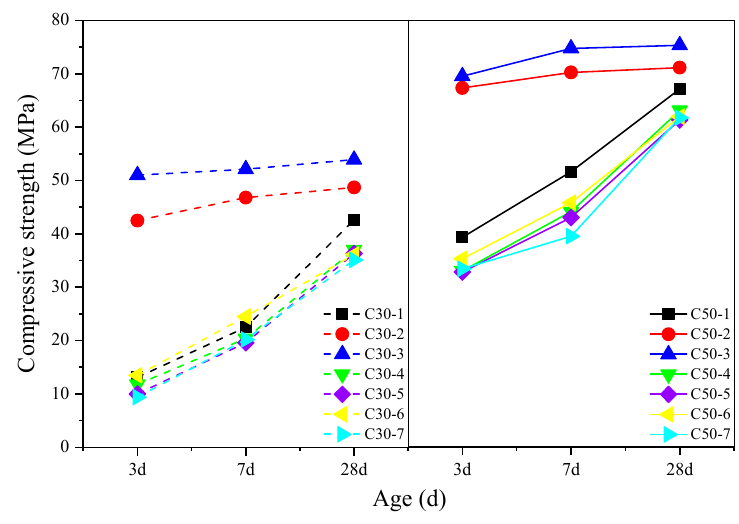
Figure 2. E ff ect of early age curing on compressive strength of Figure 2. Effect of early age curing on compressive strength of AASC.